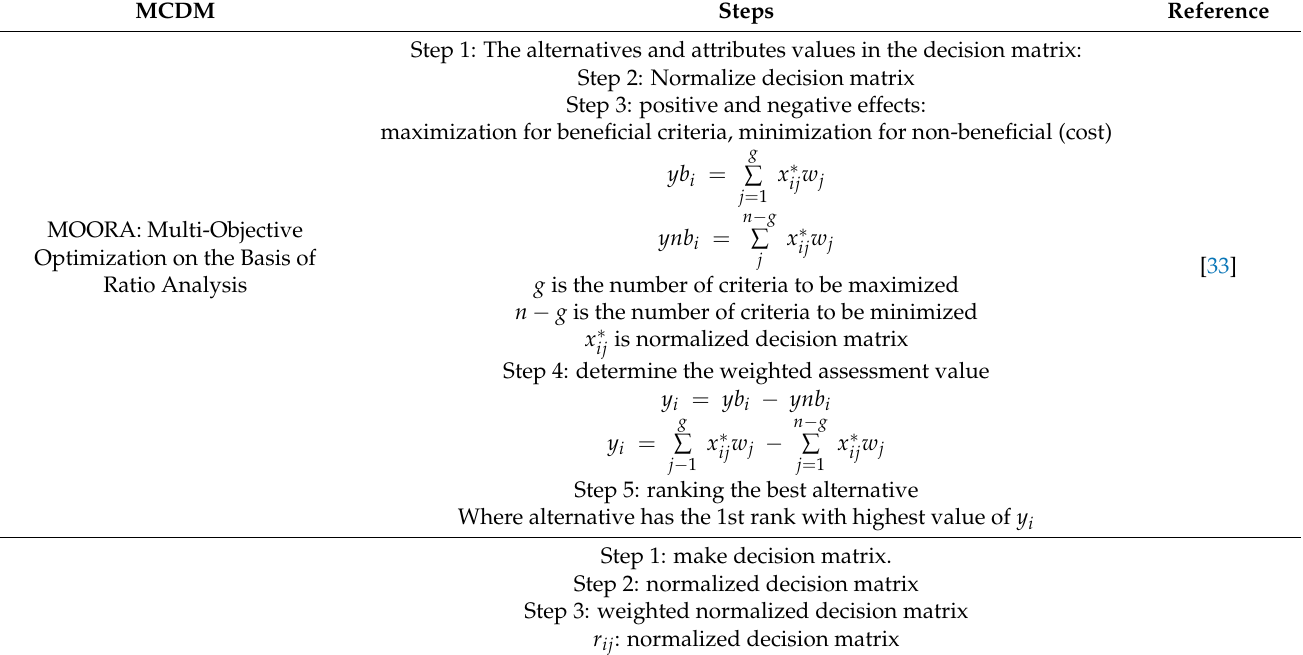
Table 1. Cont. MCDM Steps Reference